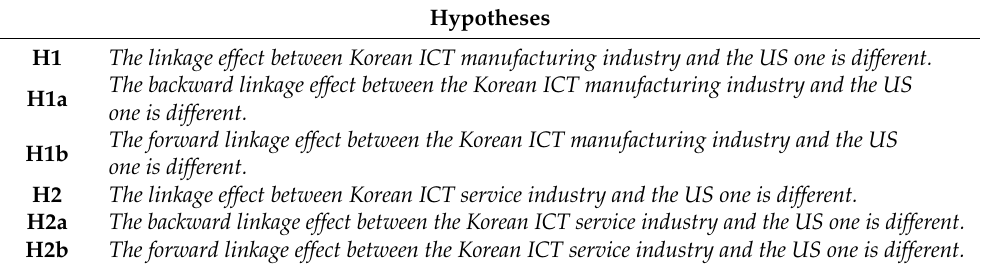
Table 7. Statistical Hypotheses of the Regression